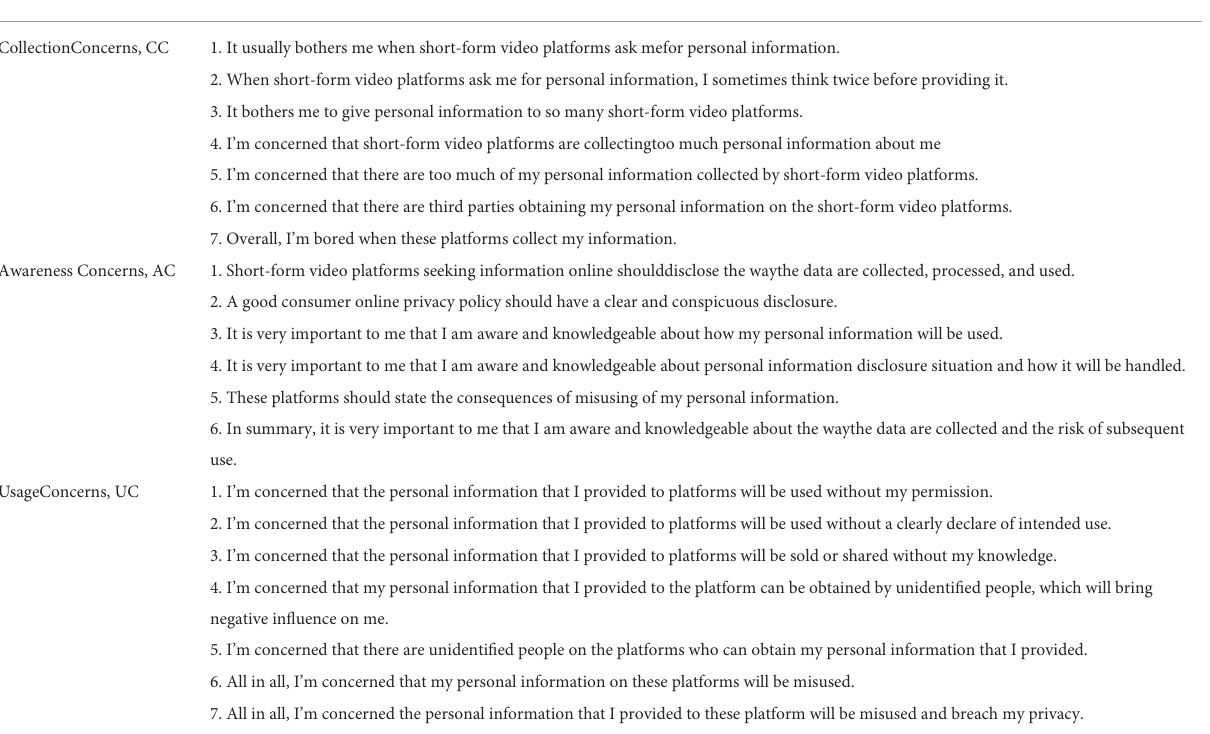
TABLE 3 Analysis of interview